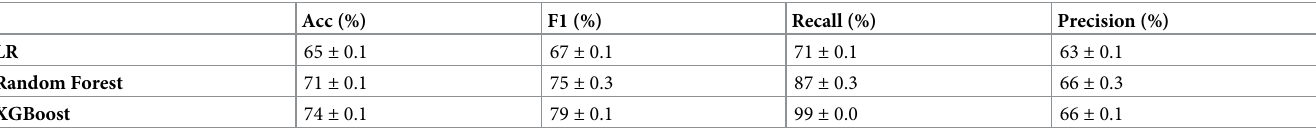
Table 6. This table shows the results of the machine learning models using data from the APC